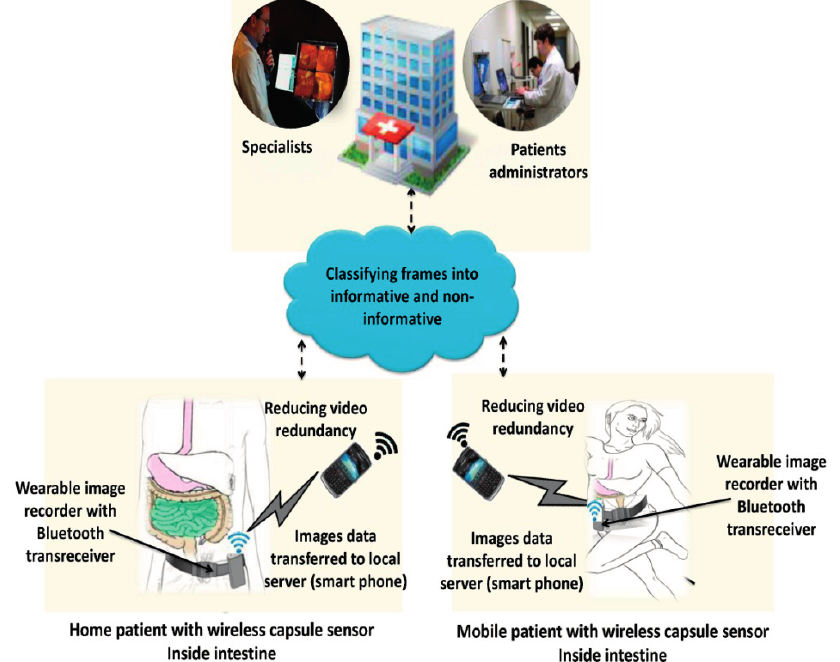
Figure 1. Conceptual view of the proposed summarization driven WCE monitoring